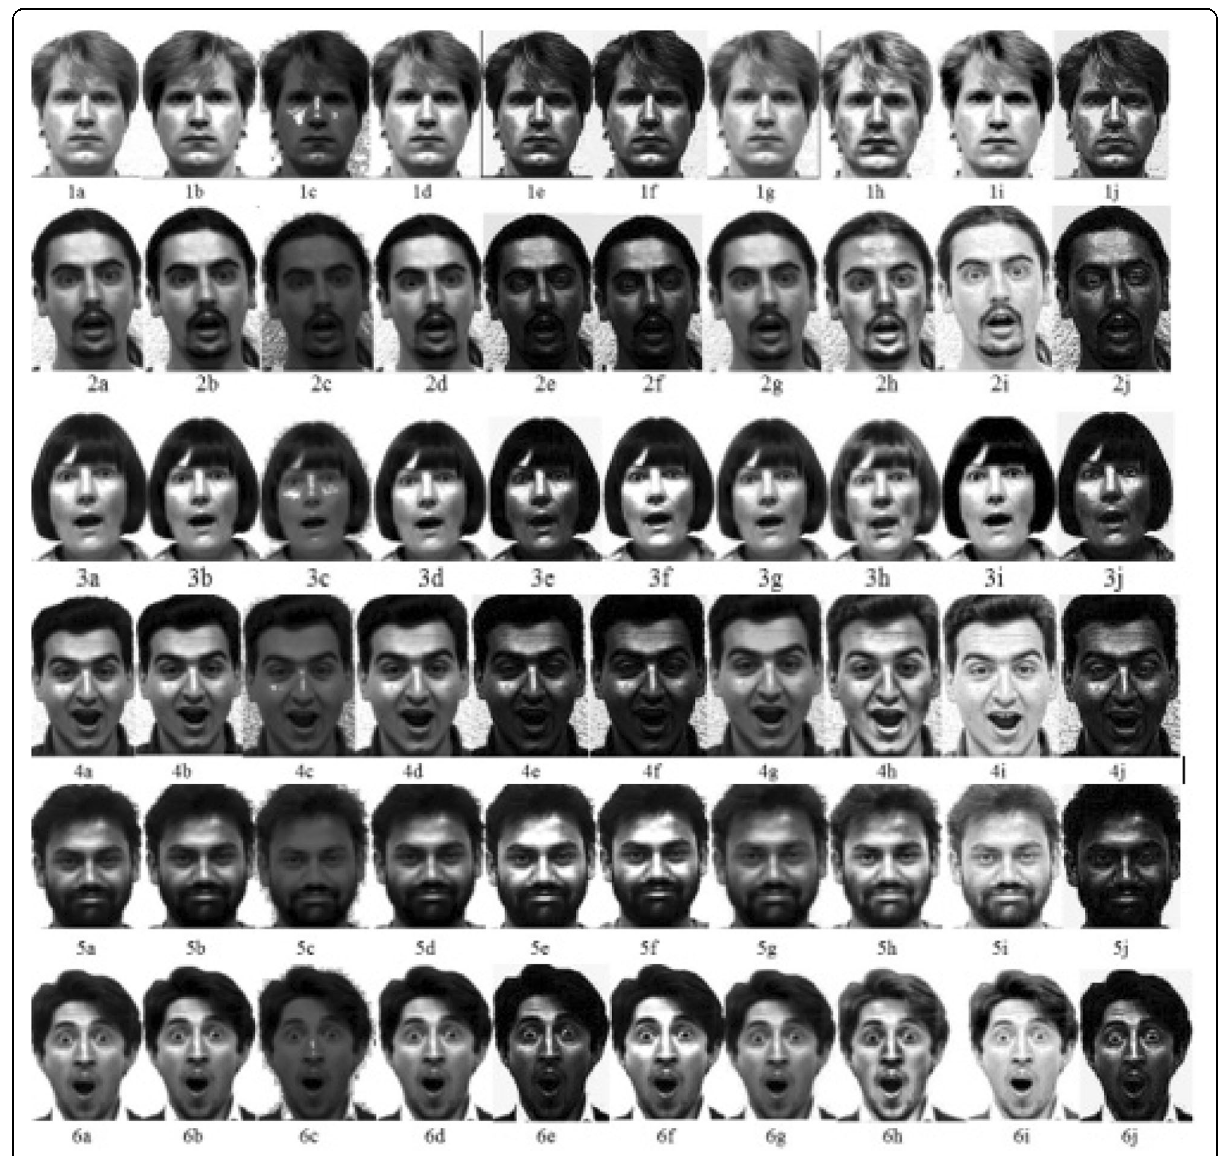
Fig. 10 Qualitative comparison of the different image enhancement algorithms on the Yale face dataset where Figs. 1, 2, 3, 4, 5, and 6 represent images of different subjects respectively. and a – j denote the methods labeled as a original, b LCC, c HE, d IIA, e M_PSO, f M_GA, g BDPFHE, h CLAHE, i LLIE, and j